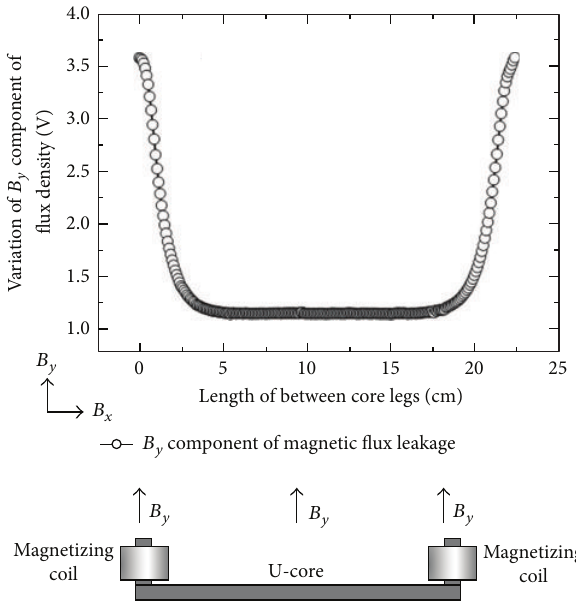
Figure 5: Variation of the 𝐵 𝑦 component of the magnetic flux leakage without sample between core legs.